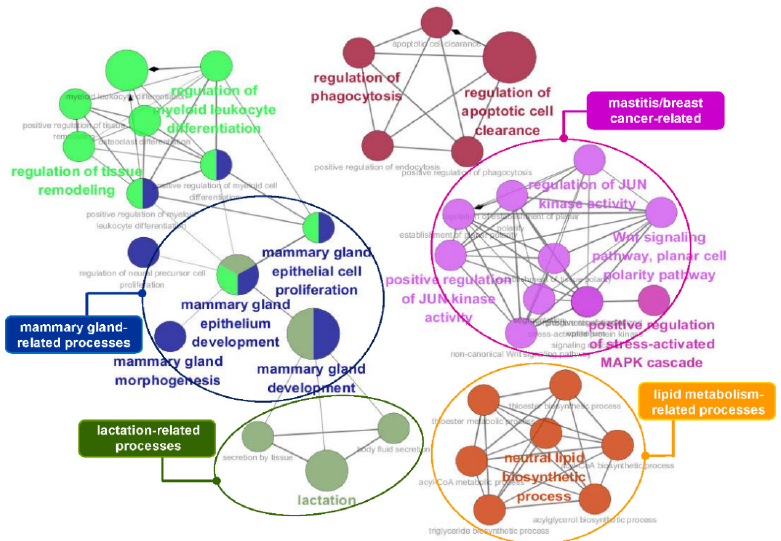
Figure 5. Gene ontology (GO) functional enrichment analysis of the 75 identified genes that overlapped with the lipid metabolism and intramuscular fat genes. The analyzed GO network consisted of distinct functional groups that are associated with energy- and lipid-related processes, such as triglyceride, fatty acid, and glucose metabolism as well as fat cell differentiation. The development of muscle- and bone-related processes is also annotated. The GO functionally grouped networks use terms as nodes (Bonferroni p -value < 0.05) and are linked according to their kappa score level ( ≥ 0.4). The size of the nodes corresponds to the statistical significance of the terms.